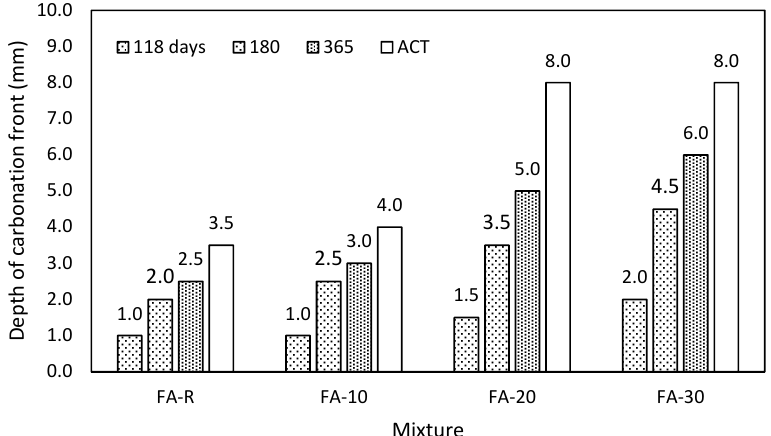
Figure 11. Comparison of natural carbonation in time and the accelerated test on studied mixtures.